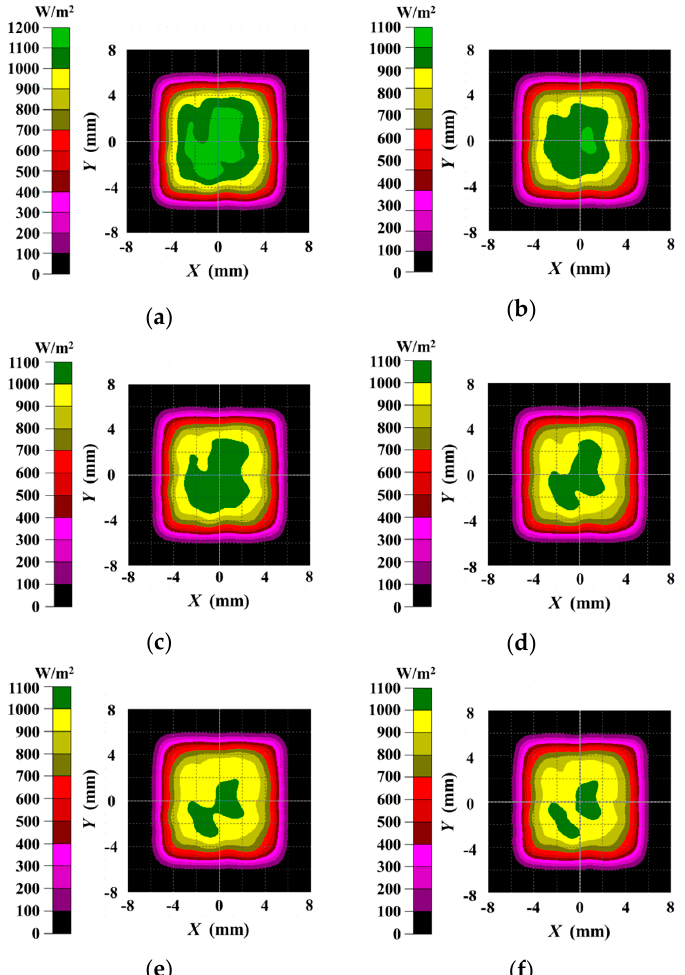
Figure 8. The luminous flux distribution in the region 0.5 mm above the top aperture. ( a ) The distance between the USLS and the workpiece surface is 30 mm and the reflection characteristic of the workpiece meets Equation (1); ( b ) The distance between the USLS and the workpiece surface is 30 mm